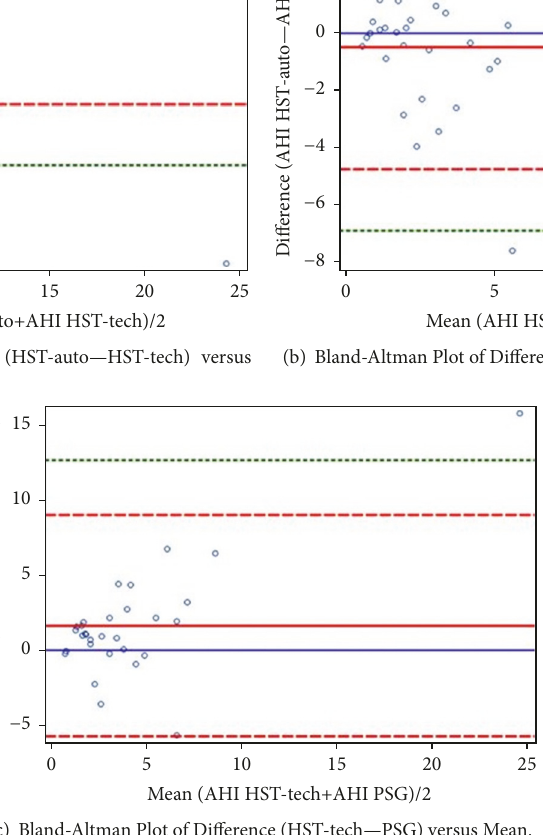
(c) Bland-Altman Plot of Difference (HST-tech—PSG) versus Mean. Figure 2: (a)–(c) Bland-Altman plots of AHI comparisons. (a) HST-auto vs. HST-tech, (b) HST-auto vs. PSG, and (c) HST-tech vs. PSG. Blue solid lines are a zero reference, red solid lines are the mean difference, dashed red lines represent the ± 2 standard deviations from the mean, and dashed green line represents the ± 3 standard deviations from the mean (for image resolution, given ranges, not all standard deviation lines were graphically